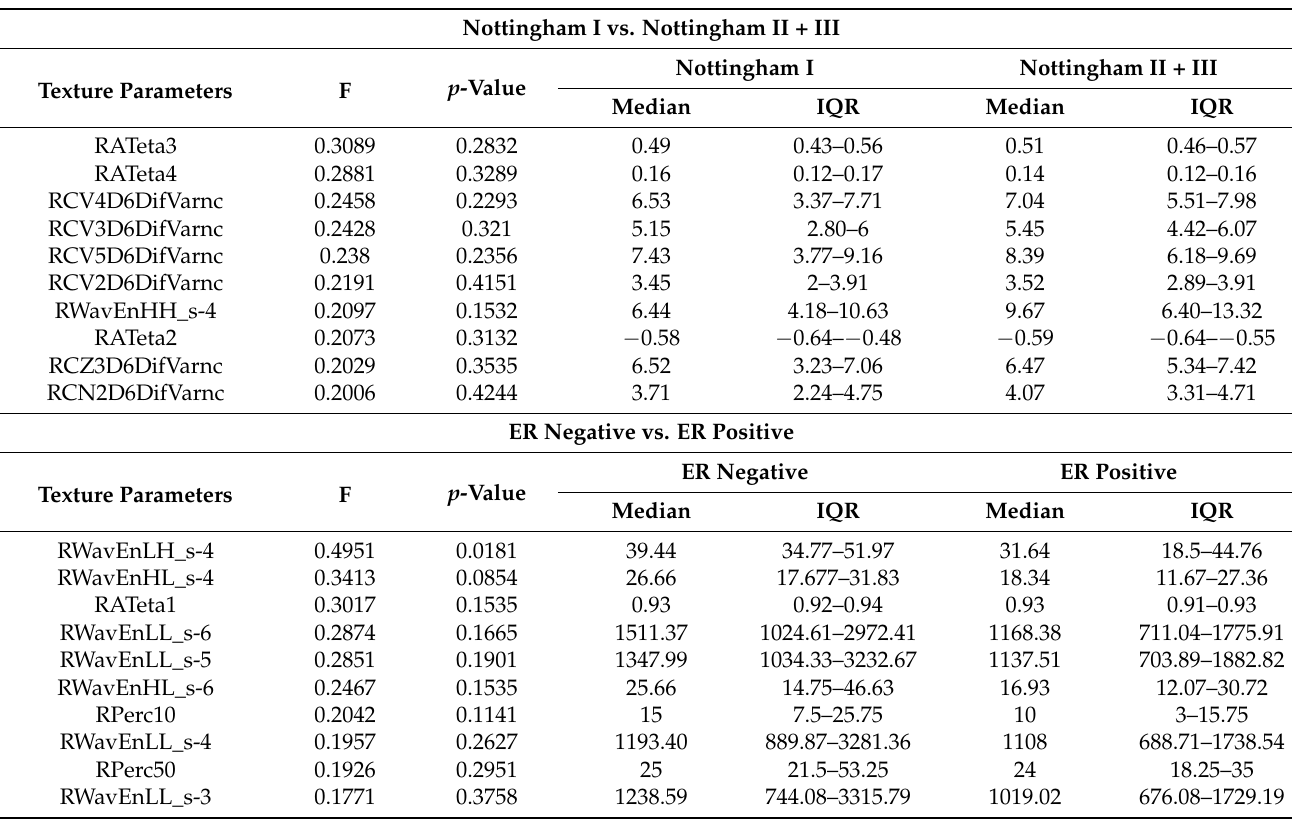
Table 3. Texture parameter depending on histological